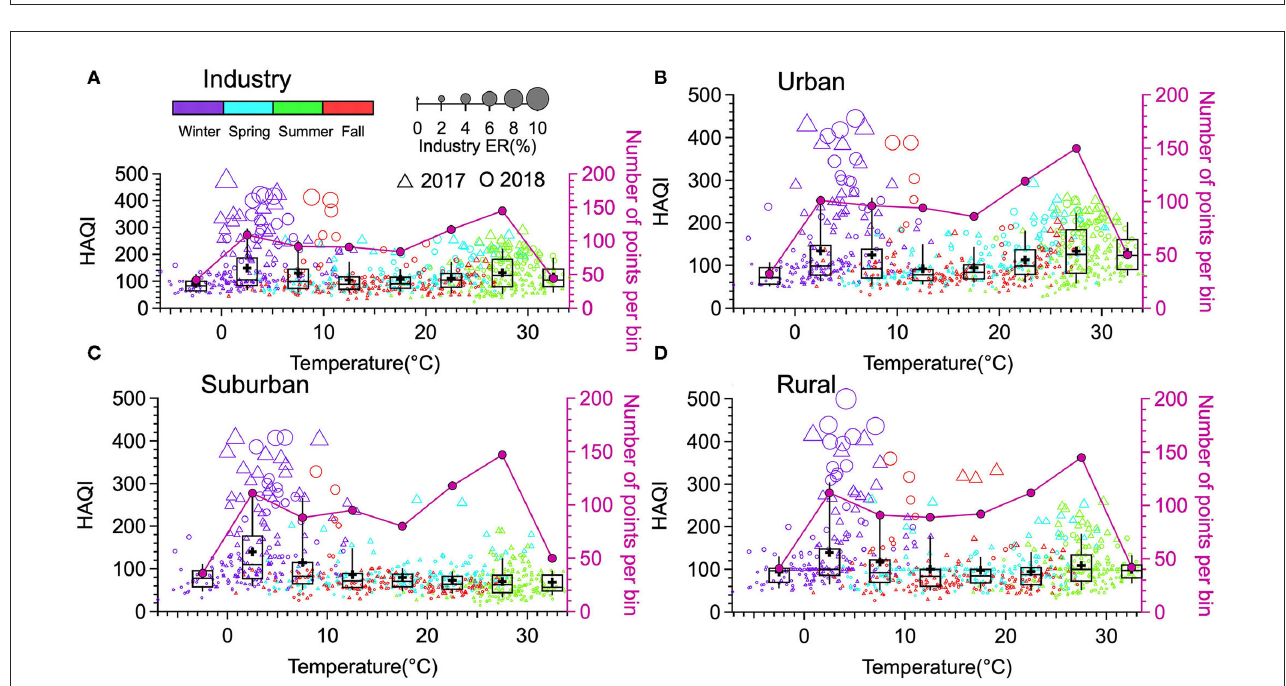
FIGURE9 The HAQI variation depends on the temperature in the four functional areas ( A : Industry; B : Urban; C : Suburban; D : Rural) in Jining. The triangles (HAQI in 2017) and circles (HAQI in 2018) indicate the distribution of HAQI events in each temperature bin, with the circle size depending on the ER values and the circle color indicating the